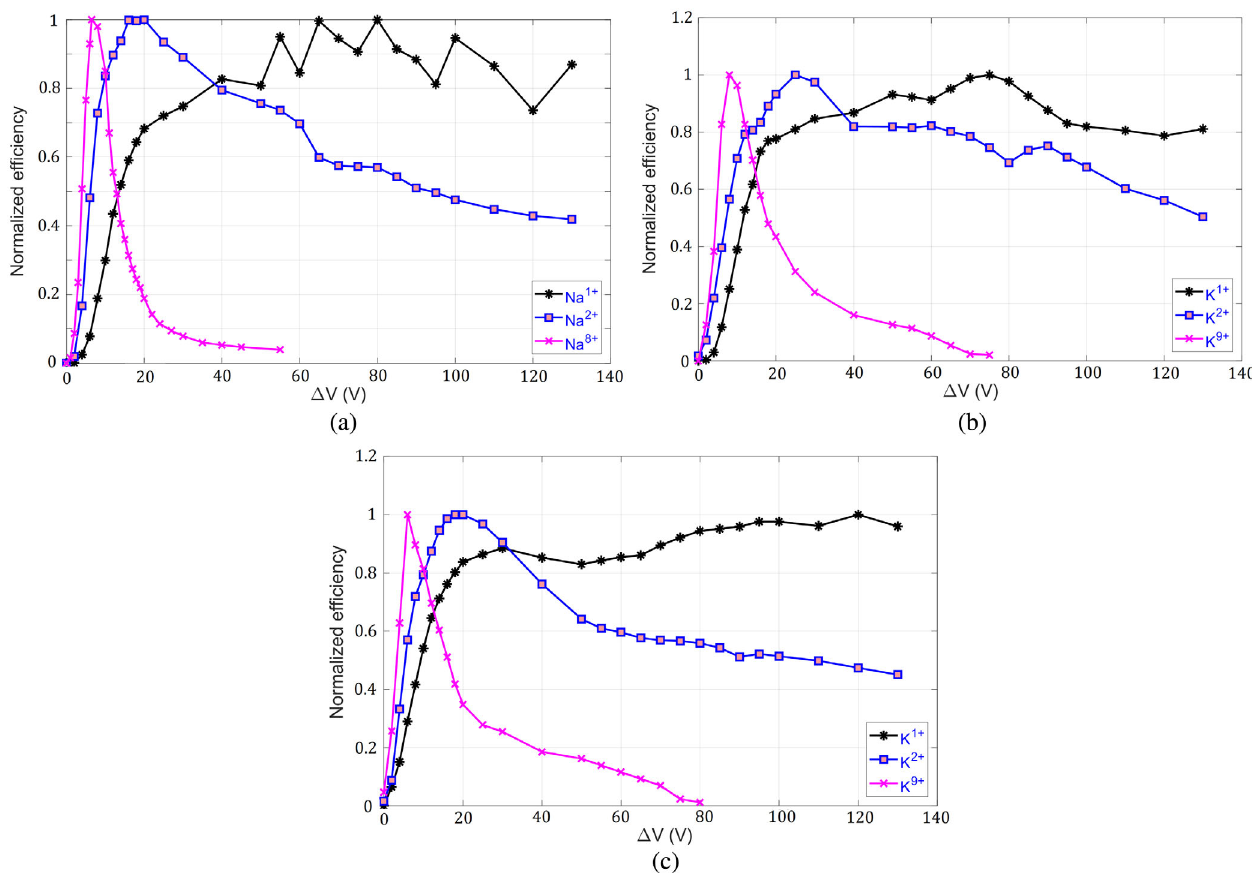
FIG. 2. Normalized experimental Δ V curves of various charge states of (a) 23 Na in He plasma, (b) 39 K in He, and (c) 39 K in O 2